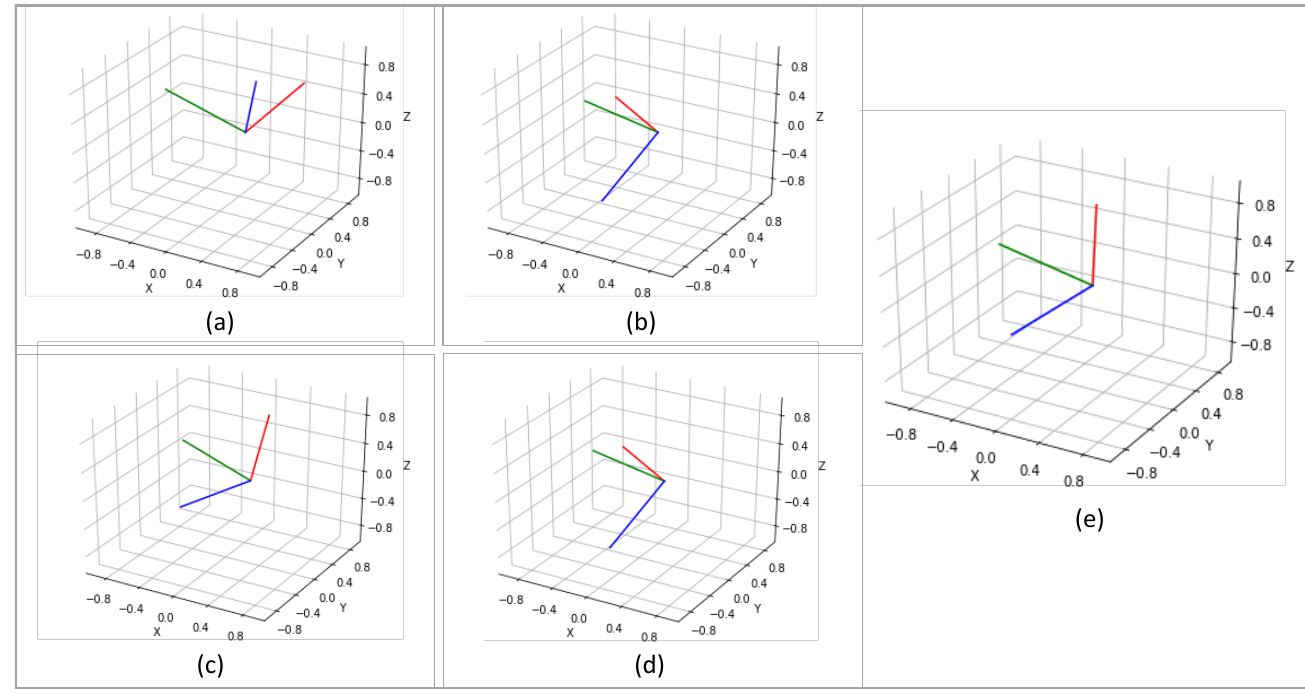
Figure 10. In ( a – d ), we plot the rotation matrix (variable mapping function) of XSens DOT sensors to MVN sensors for different persons on different recording sessions (only right forearm sensor is shown here). In ( e ), we plot the fixed rotation function (fixed mapping function). The fixed mapping function (using Equation (24)) is the quaternion average of the other four rotations. In each graph, the red, green, and blue lines correspond to the x , y , and z axes of each rotation